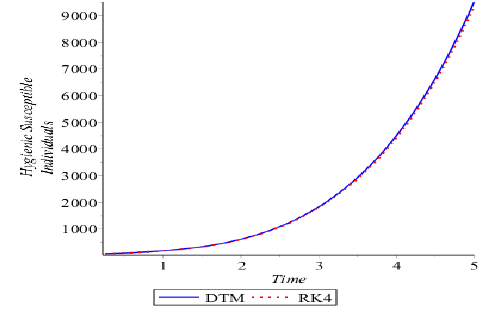
Figure 3 : Solution of Hygienic Susceptible Individuals